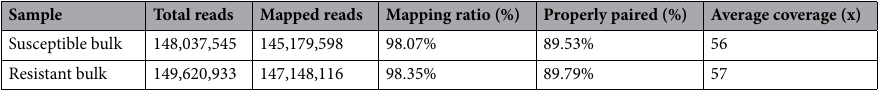
Table 1. Mapping statistics for short reads generated by sequencing of the resistant and susceptible DNA bulks.